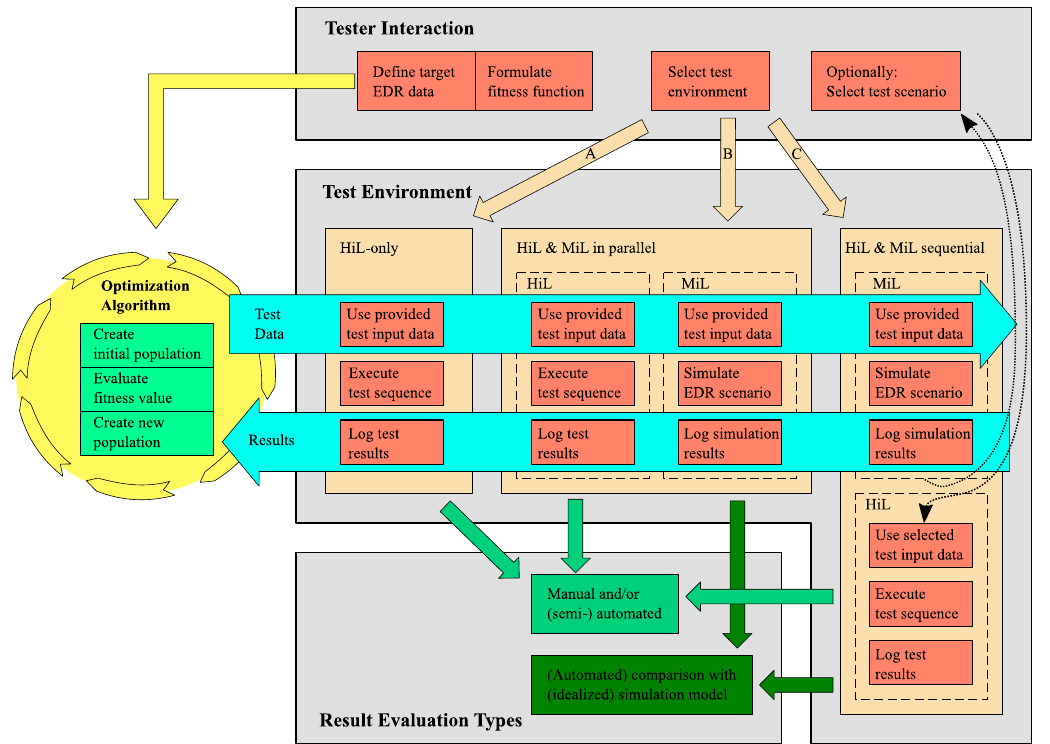
Figure 13. Available options of automated test execution considering the test environment.